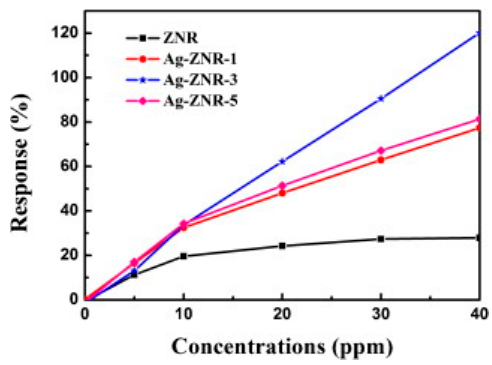
Figure 59. HCHO sensing response of ZnO and Ag-ZnO nanorods under 370 nm irradiation. Reproduced with permission from [86].